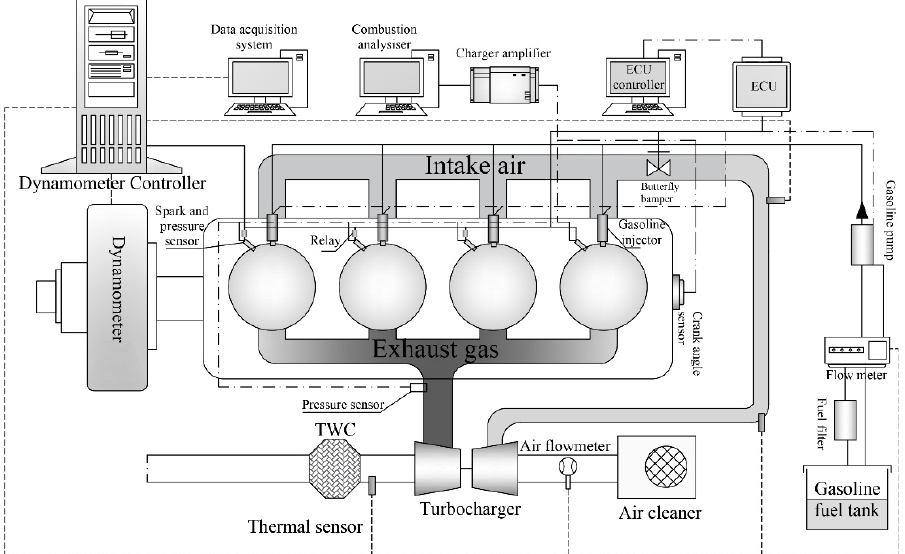
Figure 1. Schematic of the engine test setup.